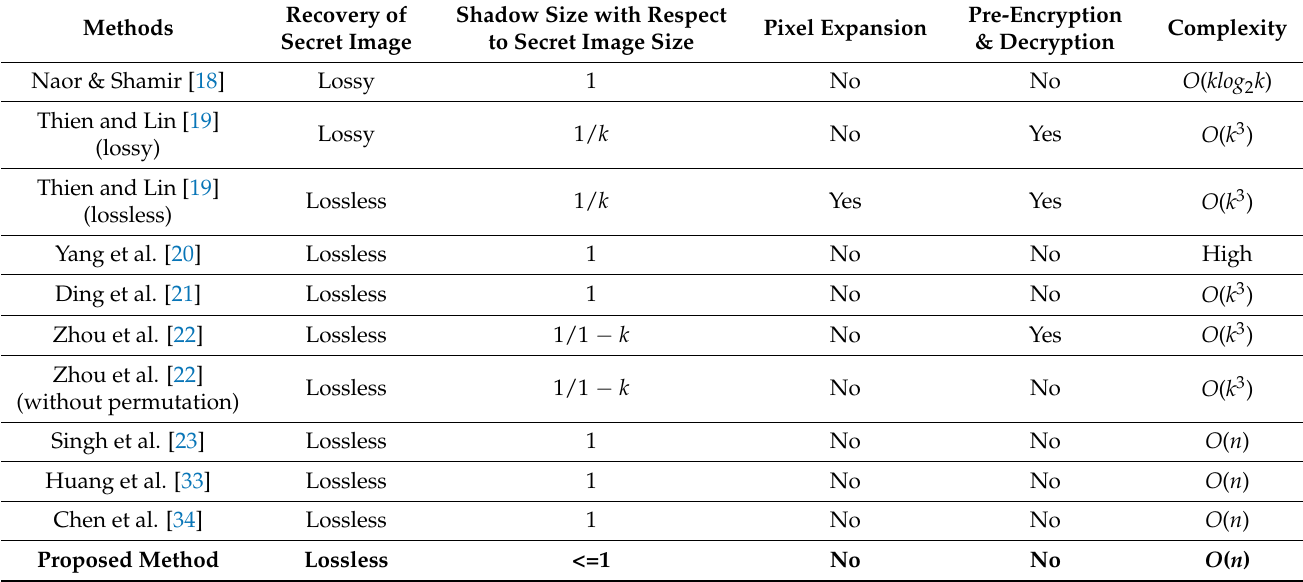
Table 3. Comparisons of significant attributes.